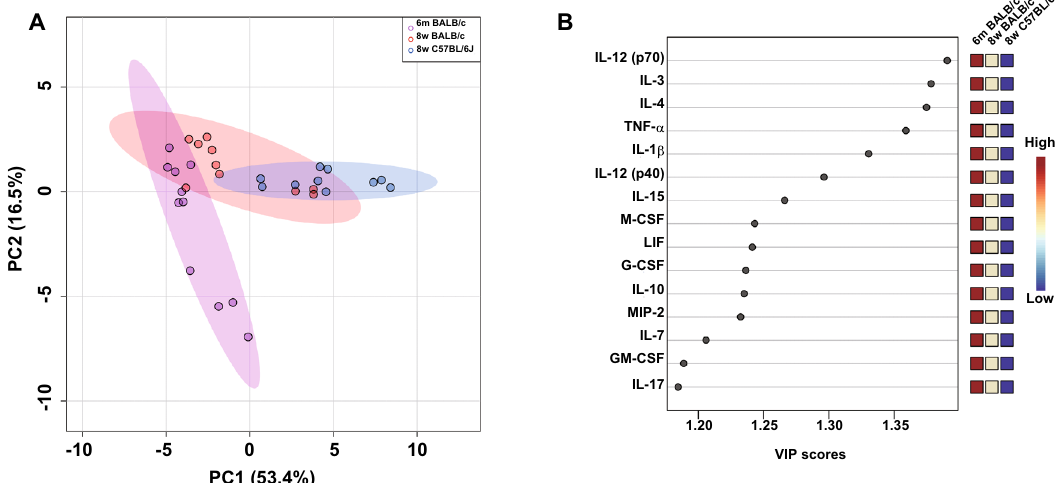
Figure 6. Principal component analysis (PCA) and the variable importance in projection (VIP) scores of lung-specific cytokines/chemokines induced in young C57BL/6 J mice as well as young and aged BALB/c mice following infection with the SARS-CoV-2 B.1.531 variant. Lung-specific cytokines and chemokines were subjected to PCA, and VIP scores were obtained from partial least squares-discriminant analysis (PLS-DA). ( A ) The two most significant principal components (PC1 and PC2) contained approximately 70% of the variance, which distinguished young C57BL/6 J mice and aged BALB/c mice based on the cytokine/chemokine profiles. Young BALB/c mice showed intermediate features compared to the other two groups. Each color ellipse represents a 95% confidence region. ( B ) VIP scores (top15) for cytokine/chemokine signatures facilitating the differences among young C57BL/6 J mice and young and aged BALB/c